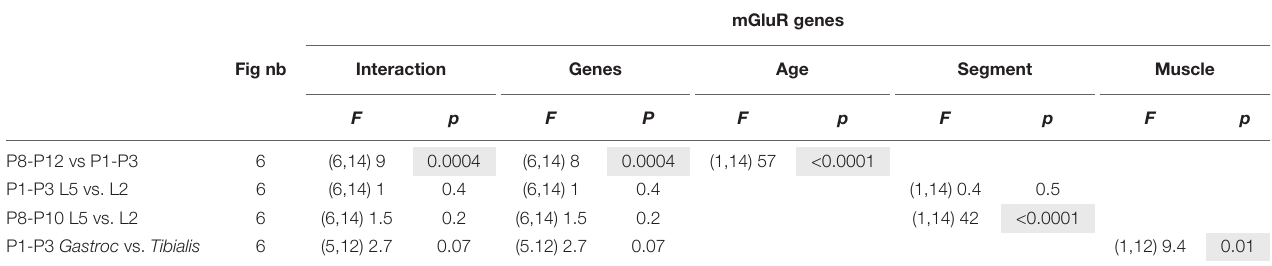
FIGURE 6 | Reverse transcription and real-time quantitative polymerase chain reaction (RT-qPCR) analysis of the expression of mGluR genes in the developing ventral spinal cord and in flexor and extensor MNs. (A) mRNA expression of genes coding for mGluR1-5,7 in the ventral spinal cord of P8-P12 mice (hatched bars) relative to their respective expression in P1-P3 animals (solid bars). (B) mGluR gene expression in the ventral L5 spinal segment (thick stroke bars) relative to their respective expression in the L2 segment (thin stroke bars) in P1-P3 (B1) and P8-P12 mice (B2) . (C) (C1) Lower image: longitudinal section of a lumbar spinal cord of a P3 mouse after the laser microdissection of motoneurons. Scale bar: 300 µ m. Upper images: magnification of motoneurons from the Gastrocnemius muscle that were retrogradely labeled with CTB before (left) and after (middle and right panel) laser microdissection. Scale bars: 30 µ m. (C2) mGluR gene expression in P1-P3 Gastrocnemium motoneurons (dashed bars) relative to the expression of the same genes in P1-P3 Tibialis motoneurons (solid bars). Two-way RM ANOVA followed by Sidak’s post hoc tests. * p < 0.05 and ** p < 0.01 significantly different. TABLE 5 | Results of the repeated measure two-way analysis of variances (ANOVAs) performed to test the effects of mouse age (age, P8-P12 vs. P1-P8), spinal segments (lumbar segment 2 and 5, L5 vs. L2; segments) and muscle targeted by motoneurons (MNs) ( Gastrocnemius muscle versus Tibialis muscle ; muscle) on the expression of the different metabotropic glutamate receptor (mGluR) genes. mGluR